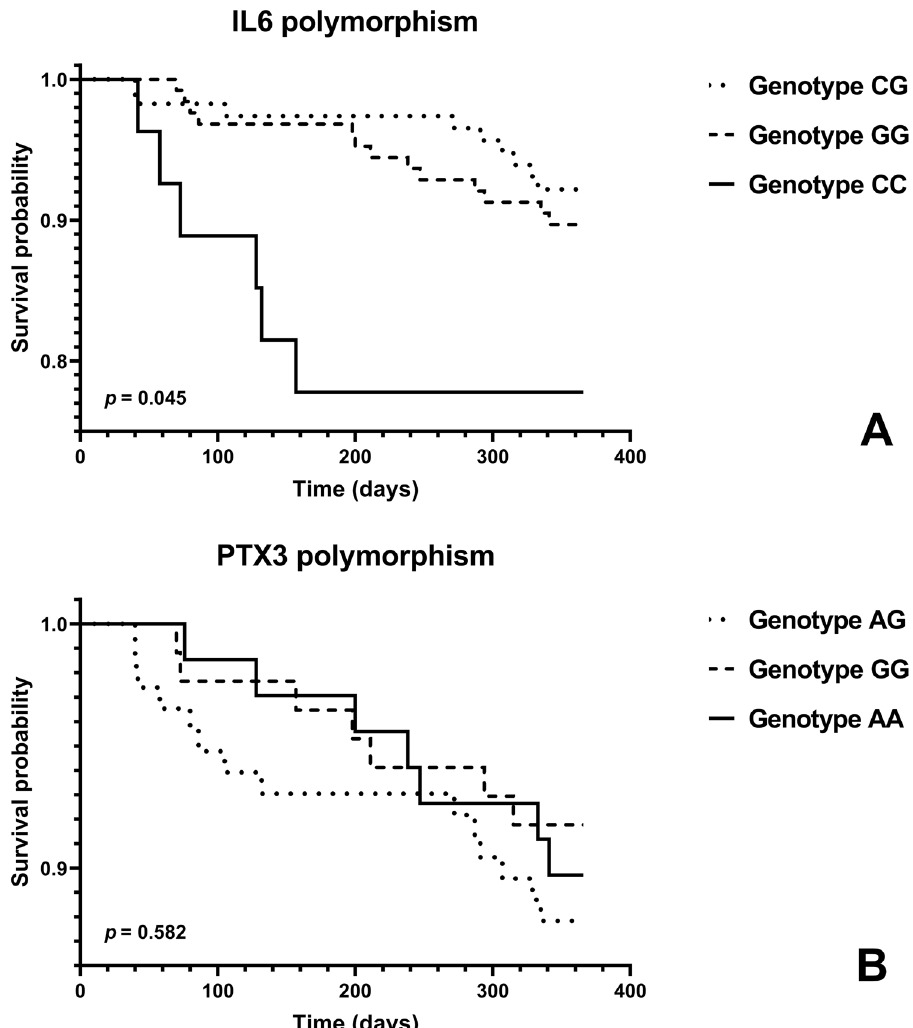
Figure 1. Survival cumulative curves for all-cause mortality in end-stage renal disease patients, by IL6 (A) and by PTX3 polymorphic genotype (B) . Survival distribution comparisons between genotypes was performed by the log-rank